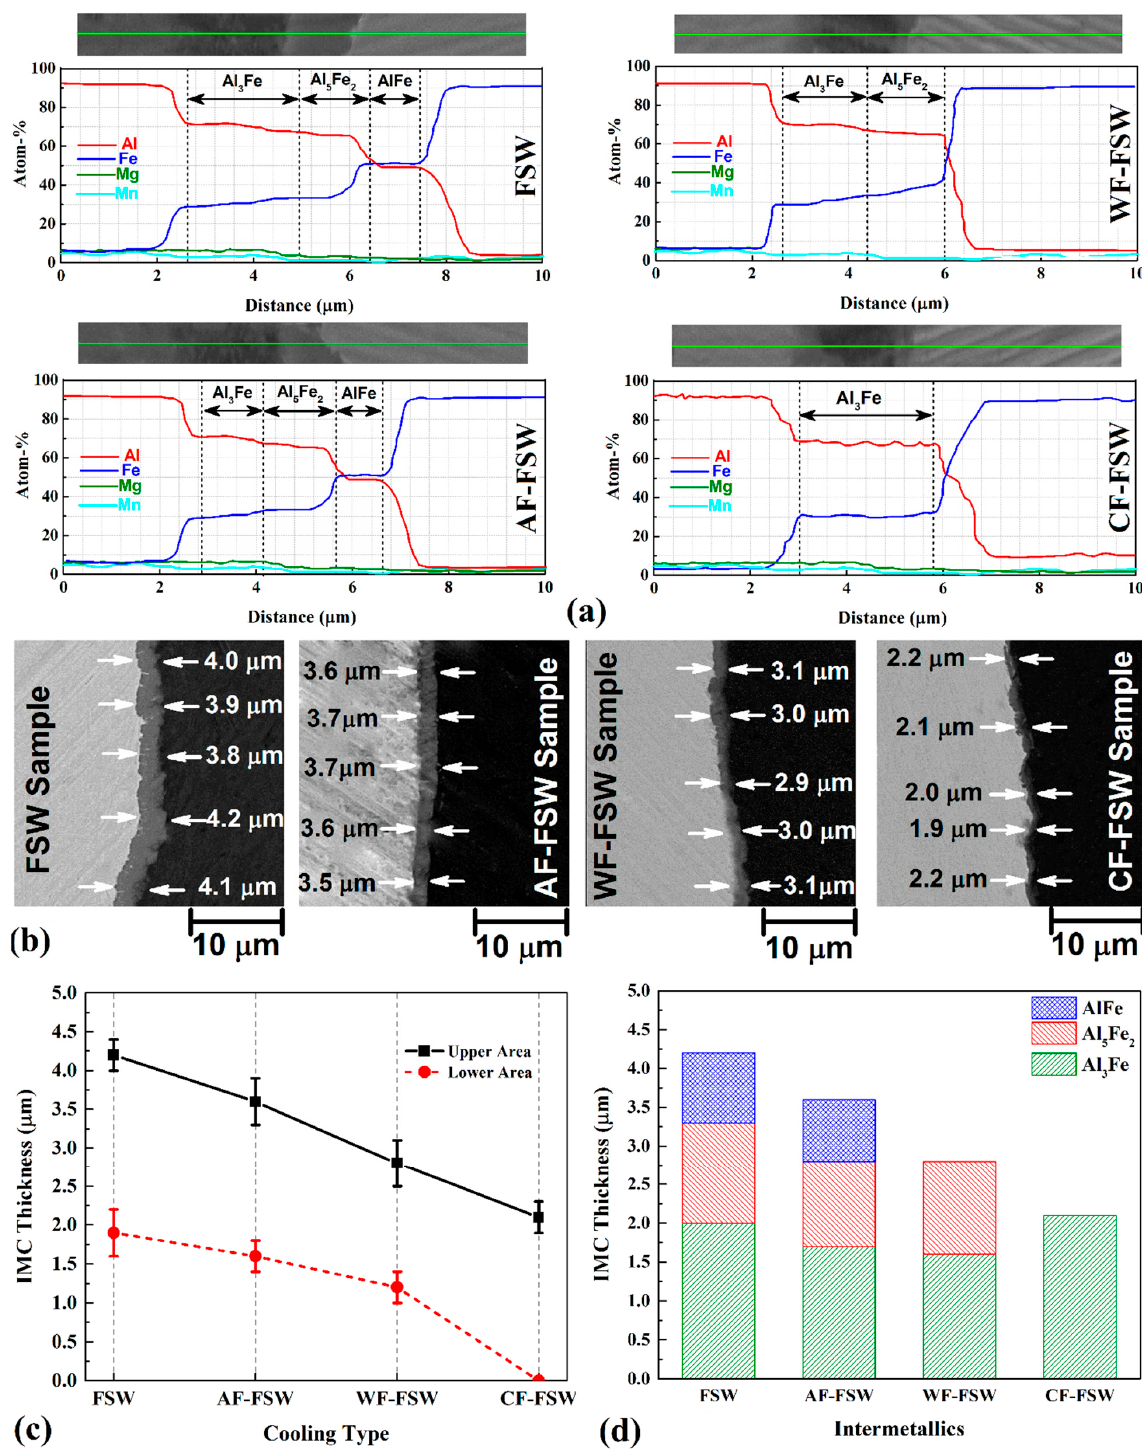
Fig. 6 Figure 6. ( a ) EDS line scan of various samples, ( b ) SEM image from interface of joints, ( c ) intermetallic compounds (IMC) thickness in top and bottom of the weld, ( d ) thickness of each IMC for different cooling